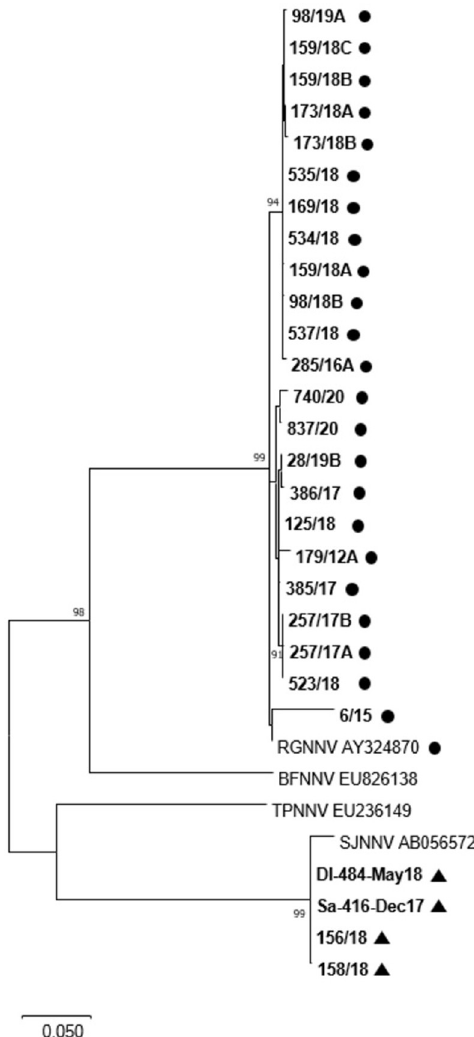
Fig 6. Phylogenetic tree based of RNA2 sequences. Phylogenetic tree based on RNA2 nucleotide sequences. Reference strain are reported with genotype name and accession number. Sequences of tested samples (bold) clustered within the RGNNV or SJNNV group according to their parental RGNNV (dot) or RGNNV/SJNNV reassortant (triangle) nature. Bootstrap values > 70% are shown. Branch lengths are scaled according to the number of nucleotide substitutions per site. The scale bar is